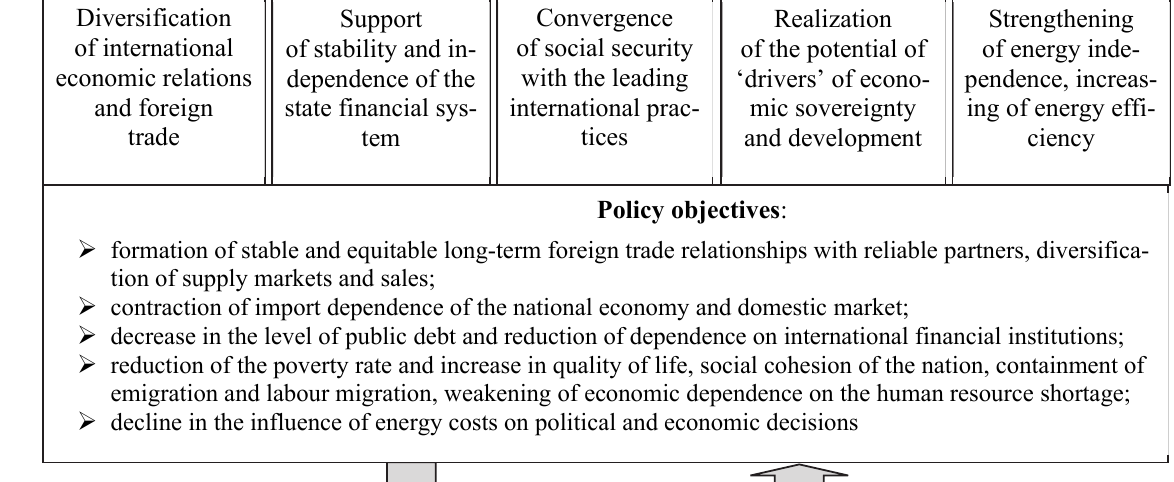
Tools for policy